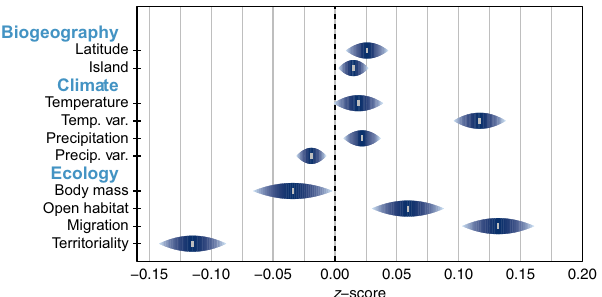
Fig. 4 Predictors of hand-wing index (HWI) in birds ( n = 9273 species). Shown are z -scores and 95% credible intervals (CI) computed with Bayesian phylogenetic mixed models; the dashed line represents a coef fi cient of 0. High z -score indicates positive association with HWI; low z -score indicates negative association with HWI. Climatic variables are calculated for each 1° × 1° grid cell of geographical range and averaged.